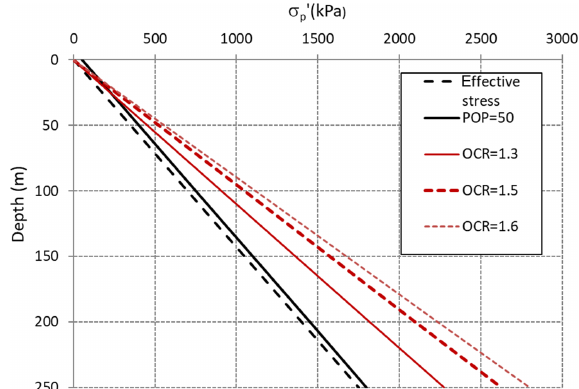
Figure 5. Preconsolidation stress of clays as a function of depth for model